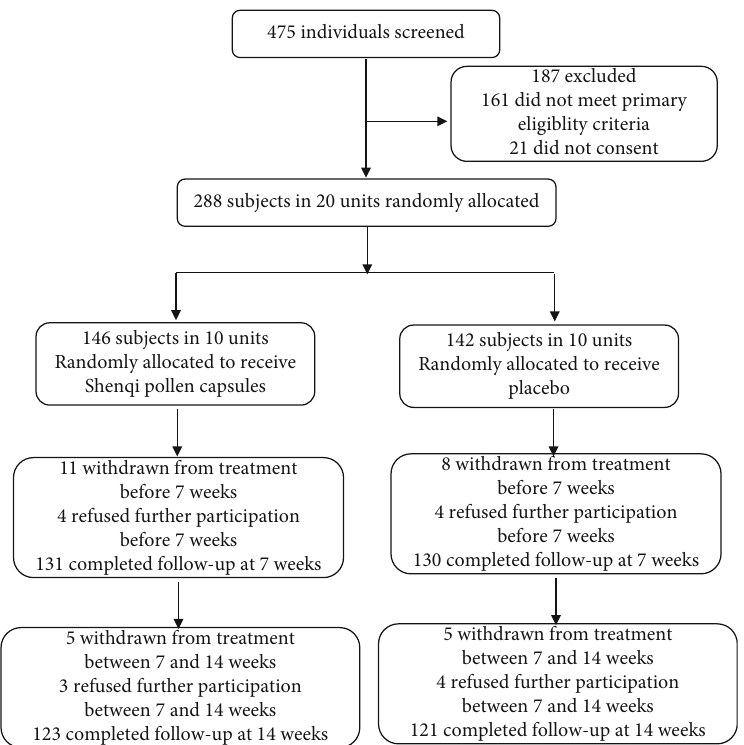
Figure 1: The fl ow diagram of the